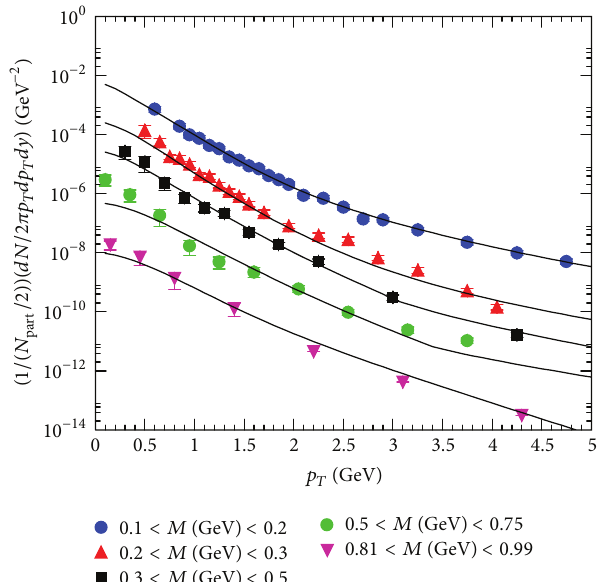
Figure 22: Transverse mass spectra of dimuons in In+In collisions at SPS energy. Solid lines denote the theoretical results [12]. Figure 23: Transverse momentum spectra of dileptons for different invariant mass windows for minimum bias Au-Au collisions at RHIC energy [12].